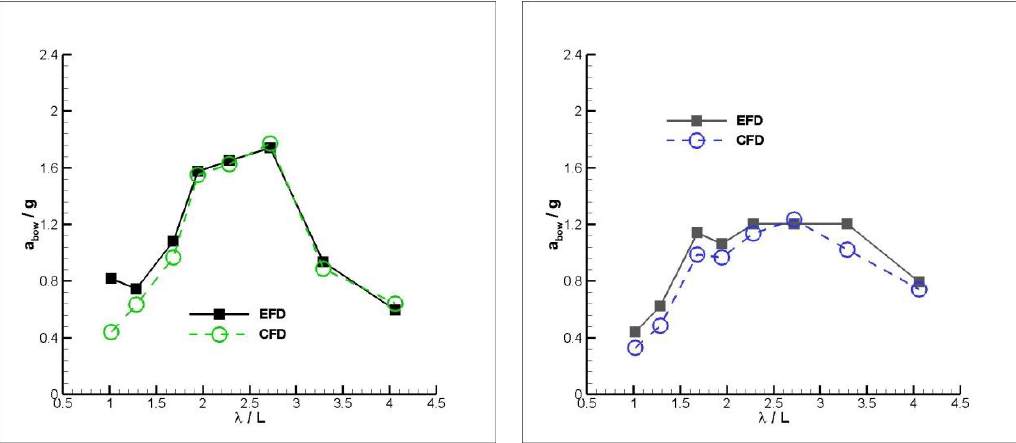
Figure 17. Bow accelerations for mono ( left ) and warped ( right ) hulls at Fn B = 2.82.